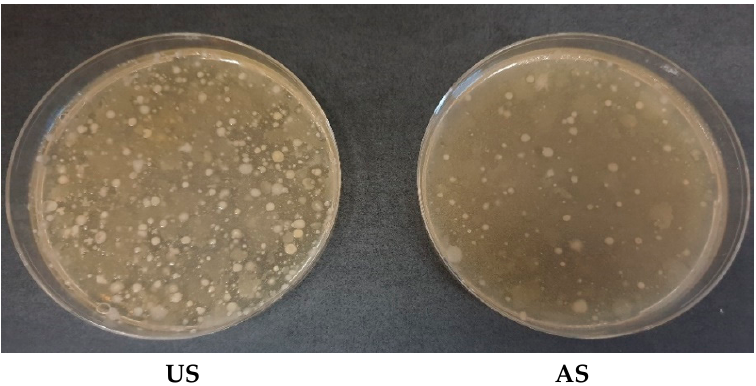
Figure 3. Microbial growth for untreated ( US ) and pre-treated slurry ( AS ). In US plates, microbial colonies were 400 cfu mL –1 , whereas in AS colonies were only 144 cfu m –1 . LF activity, evaluated as gas pressure produced in vials, mirrored microbial growth, resulting in 1.003 ± 0.063 psi in US and 0.690 ± 0.058 psi in AS. In control vials, filled with sterilized US, the measured value was 0.703 ± 0.052 psi. Our results show that air insufflation promotes a reduction in microbial growth and in LF activity in terms of gas emissions after treatment. It likely that air insufflating might have favored the growth of aerobic forms to the detriment of anaerobic ones, with a consequent reduction in CH 4 production, while the bubbling might have favored the removal of dissolved NH 3 in